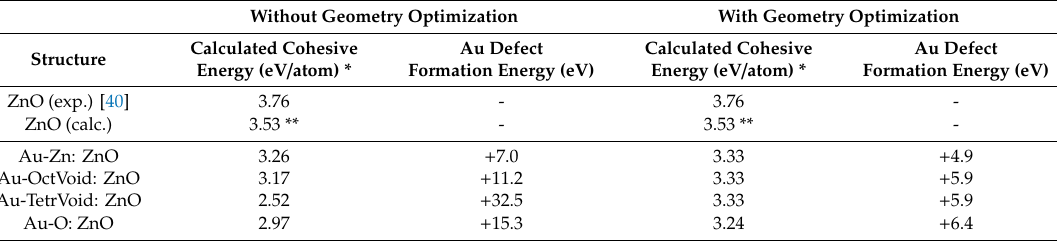
Table 2. The calculated cohesive energies (E Coh ) of geometry-optimized ZnO and Au:ZnO supercell models, together with the calculated gold defect-formation